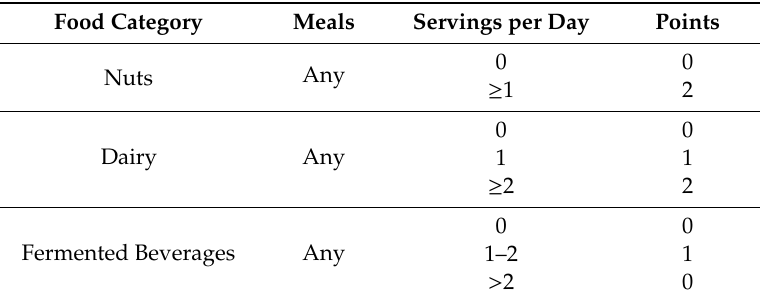
Table A2. Scoring of food groups counted on a daily basis Food Category